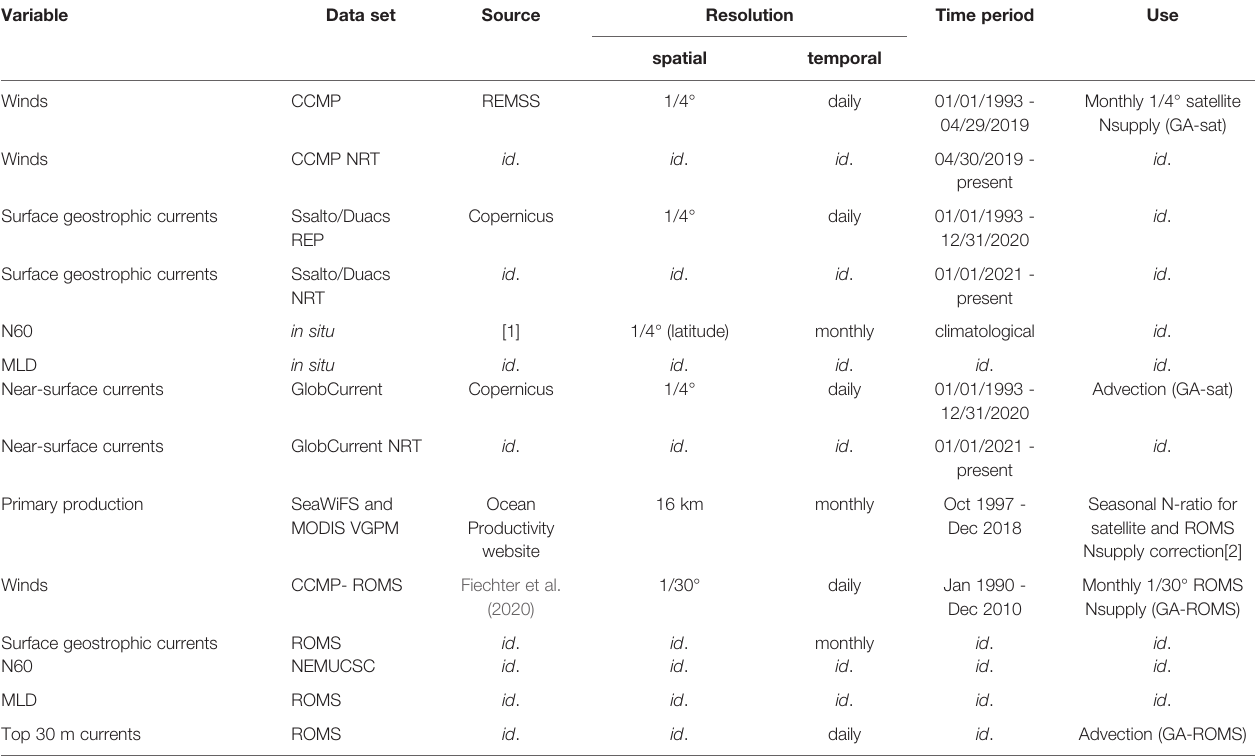
TABLE 1 | List of datasets used as inputs forcing the GA model (GA-sat and GA-ROMS runs described in section Runs and Sensitivity Experiments).